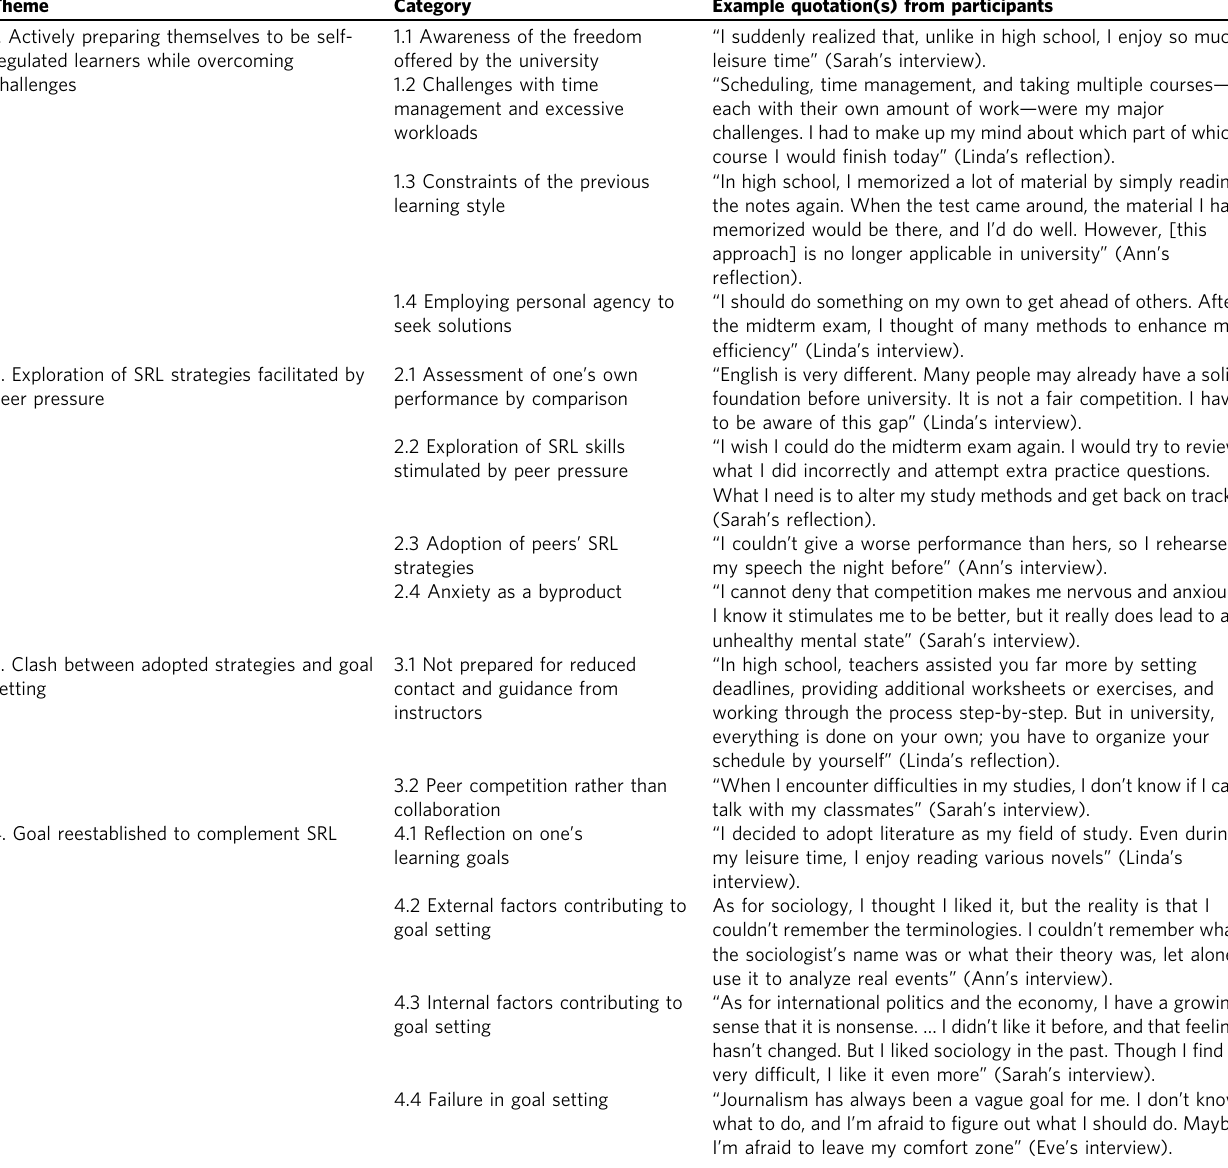
Table 2 The sample